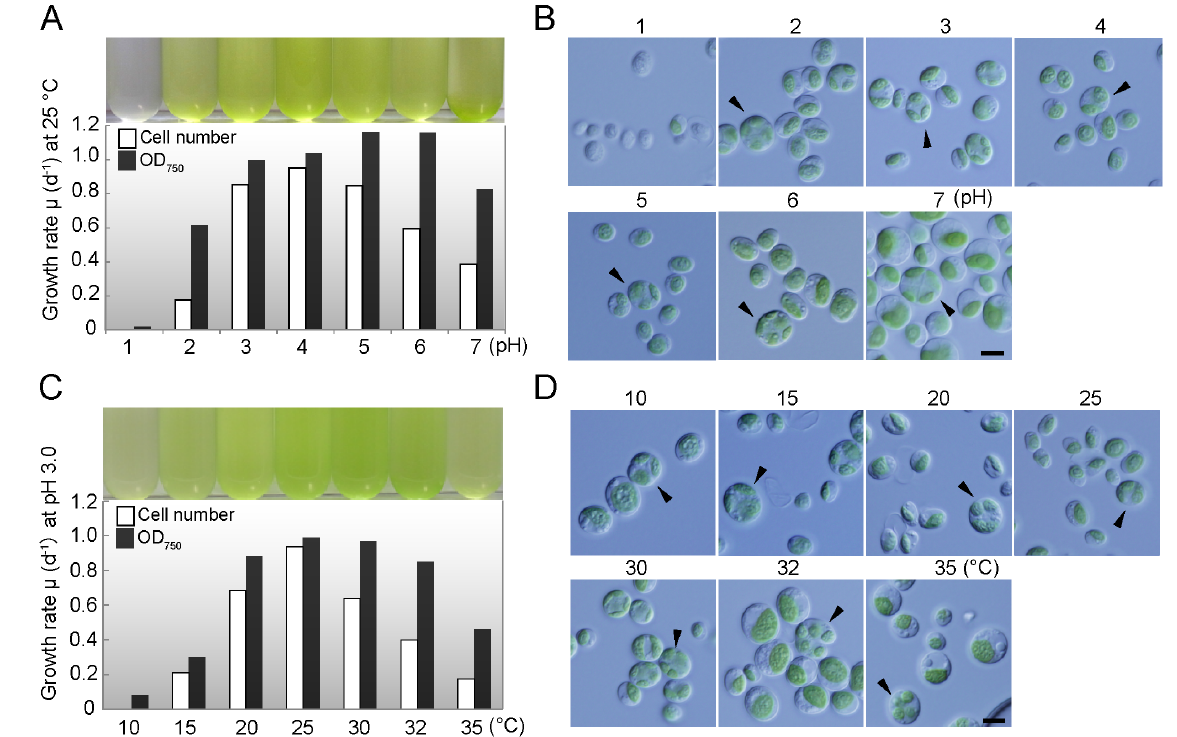
Figure 3. Growth of YKT1 under various pH and temperature conditions. (A) Photograph of the culture (1 day after the onset of culture at the indicated pH) and the growth rate based on increase in the cell number (open bars) and OD 750 (solid bars) at the indicated pH and 25 u C. (B) Micrographs showing the cells cultured at the indicated pH (from pH 1.0 to pH 7.0). The arrowheads indicate dividing cells. (C) Photograph of the culture (1 day after the onset of culture at the indicated temperature) and the growth rate based on the increase in the cell number (open bars) and OD 750 (solid bars) at the indicated temperature and pH 3.0. (D) Micrographs showing cells cultured at the indicated temperature (from 10 to 35 u C). The arrowheads indicate dividing cells. Scale bars: 5 m m (B, D).